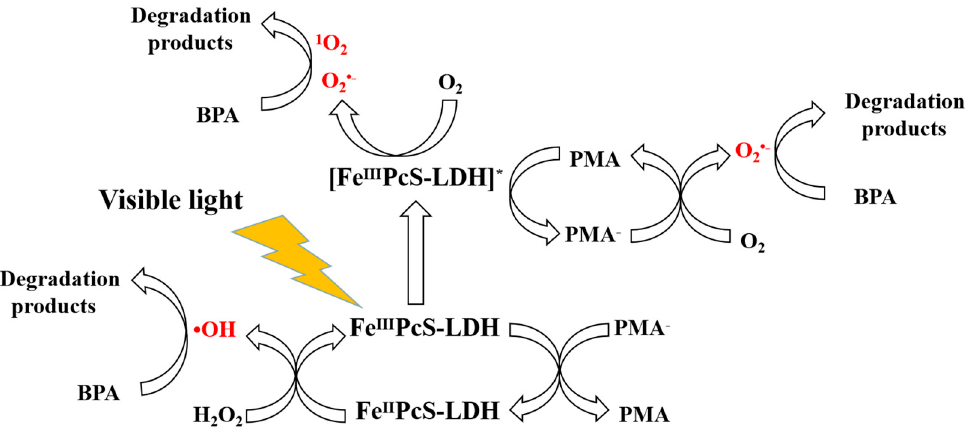
Figure 14. The possible photo-Fenton catalytic mechanism of FePcS–PMA–LDH to degrade BPA.